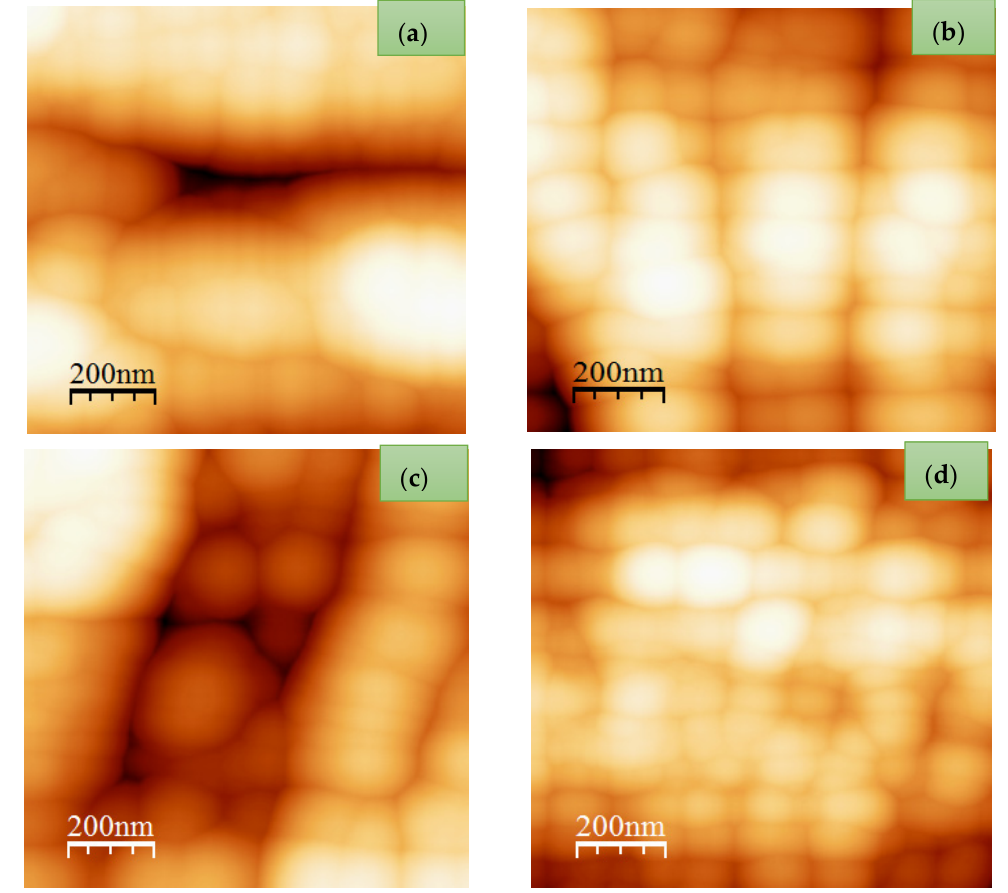
Figure 2. Two-dimensional AFM images of sample surfaces of ( a ) unimplanted, ( b ) argon ion implanted at the dose of 1 × 10 17 ions/cm 2 , ( c ) argon ion implanted at the dose of 3 × 10 17 ions/cm 2, and ( d ) argon ion implanted at the dose of 7 × 10 17 ions/cm 2 .